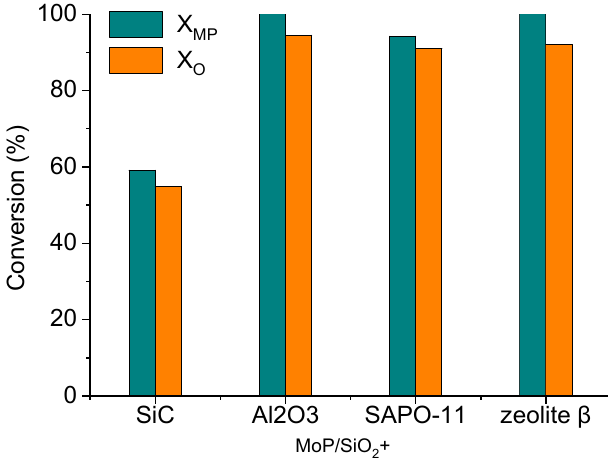
Figure 4. MP and O conversion in MP HDO over MoP/SiO 2 catalyst diluted with different materials. V cat = 0.4 cm 3 , LHSV = 60 h –1 , T = 290 °C, P H2 = 3 MPa, H 2 /feed = 600 cm 3 /cm 3 .